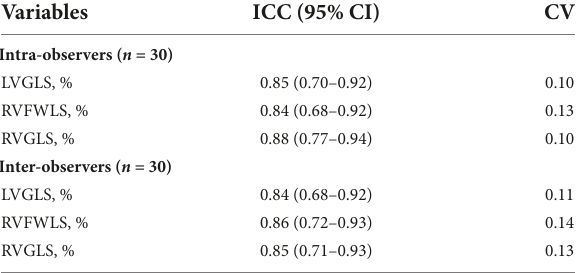
TABLE 5 Reproducibility of STE